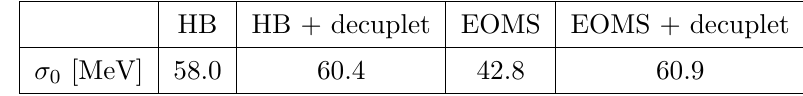
Table 8 . Values of (cid:27) 0 for the O ( p 4 ) constrained